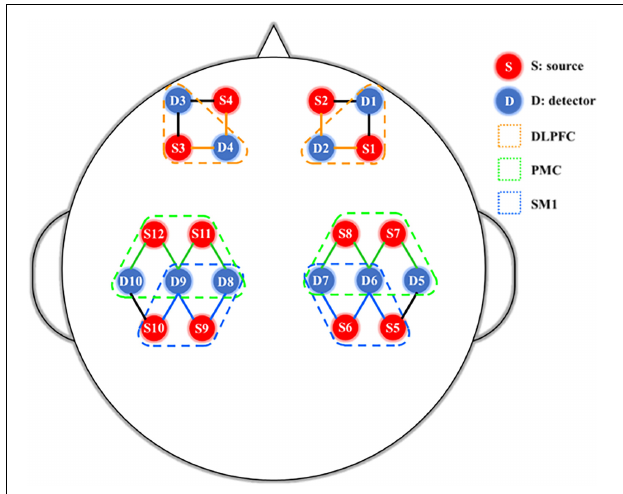
FIGURE 2 | fNIRS 24-channel placement. SM1, primary sensorimotor cortex; PMC, pre-motor cortex; DLPFC, dorsolateral prefrontal cortex.